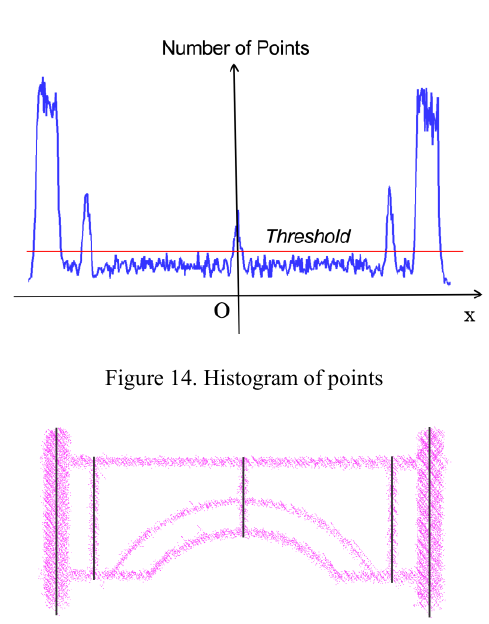
Figure 15. Skeletons of vertical pipes